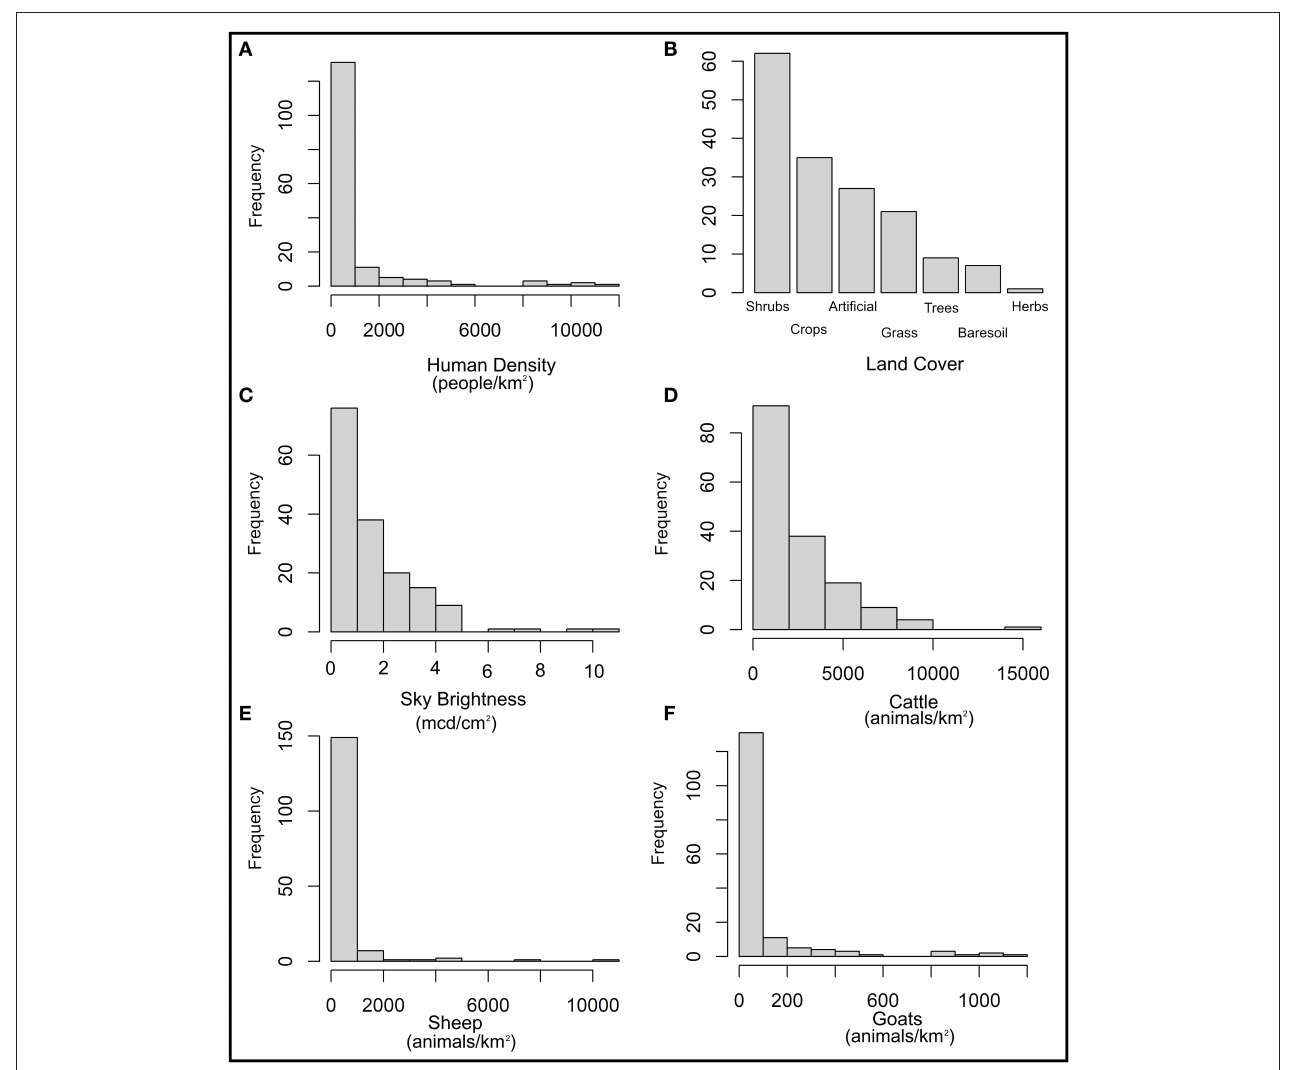
FIGURE 7 | Histograms of the six extracted variables for the 162 records. (A) Human density. (B) Land cover. (C) Sky brightness. (D) Cattle density. (E) Sheep density. (F) Goat density.